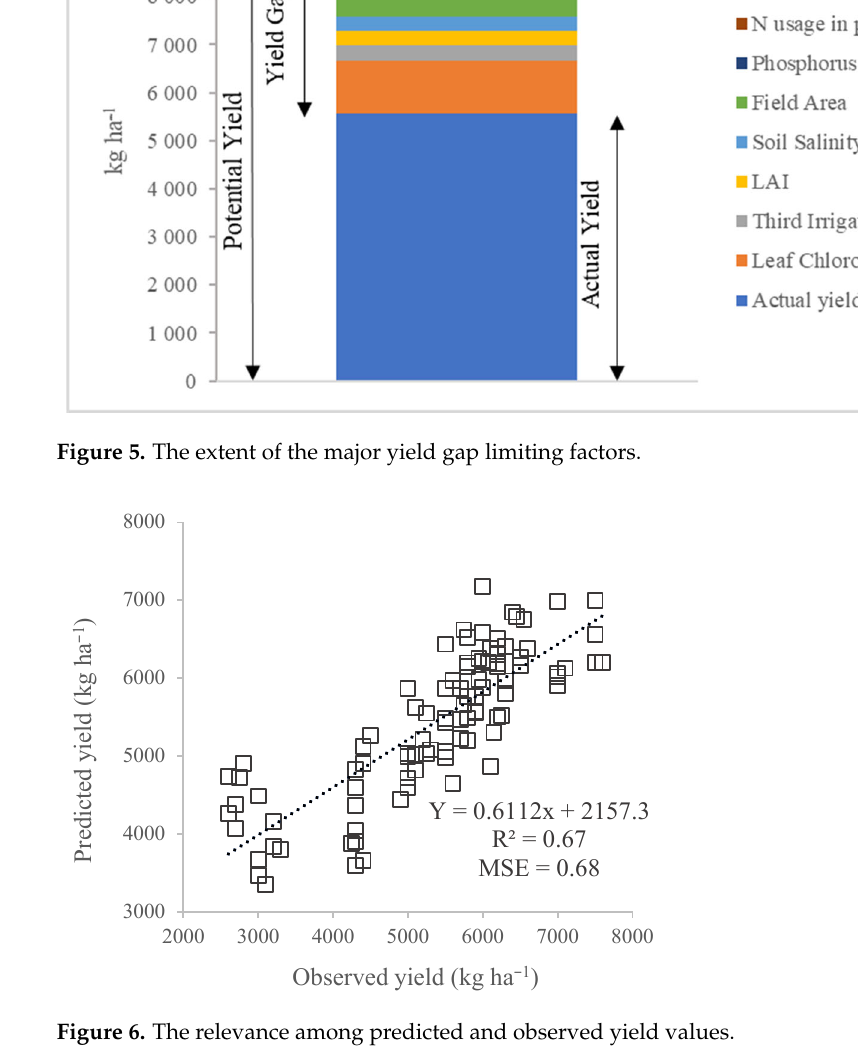
Figure 6. The relevance among predicted and observed yield values.